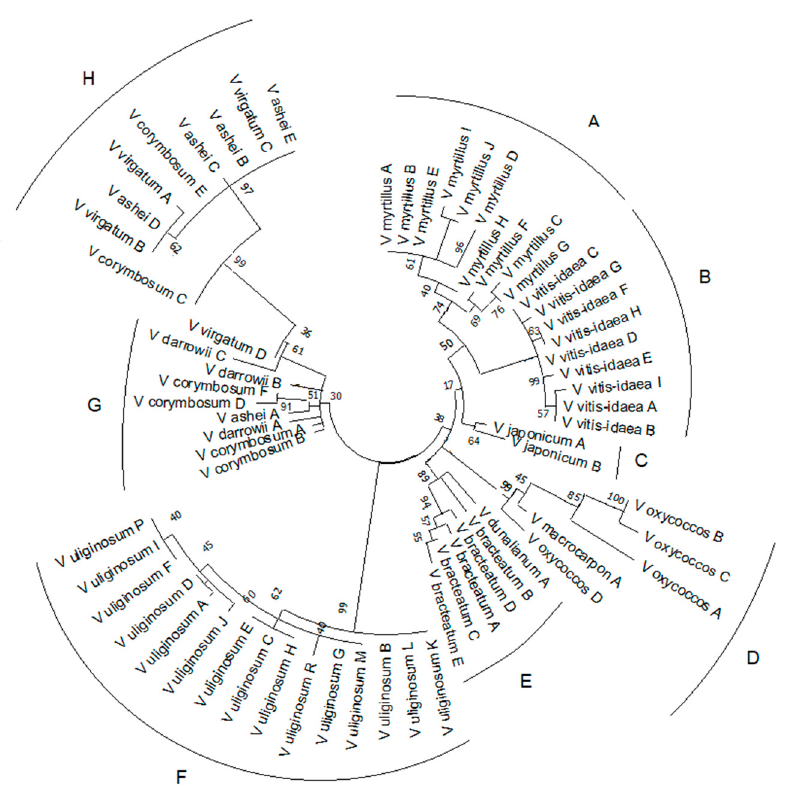
Figure 4. Phylogenetic relationships of alleles of Vaccinium rolB/C -like gene based on Maximum Likelihood method and General Time Reversible model (There were a total of 657 positions in the final dataset). ( A ) V. myrtillus , ( B ) V. vitis-idaea , ( C ) V. japonicum , ( D ) section Oxycoccus , ( E ) V. bracteatum , ( F ) V. uliginosum , ( G , H ) section Cyanococcus .